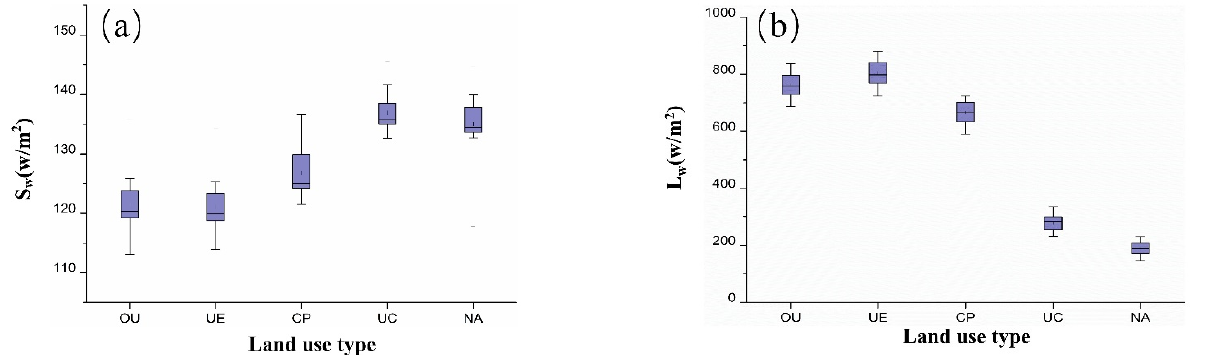
Figure 6. Statistical values of ( a ) net shortwave radiation ( S w ) and ( b ) net long-wave radiation ( L w ) based on five land types from 2000 to 2015.